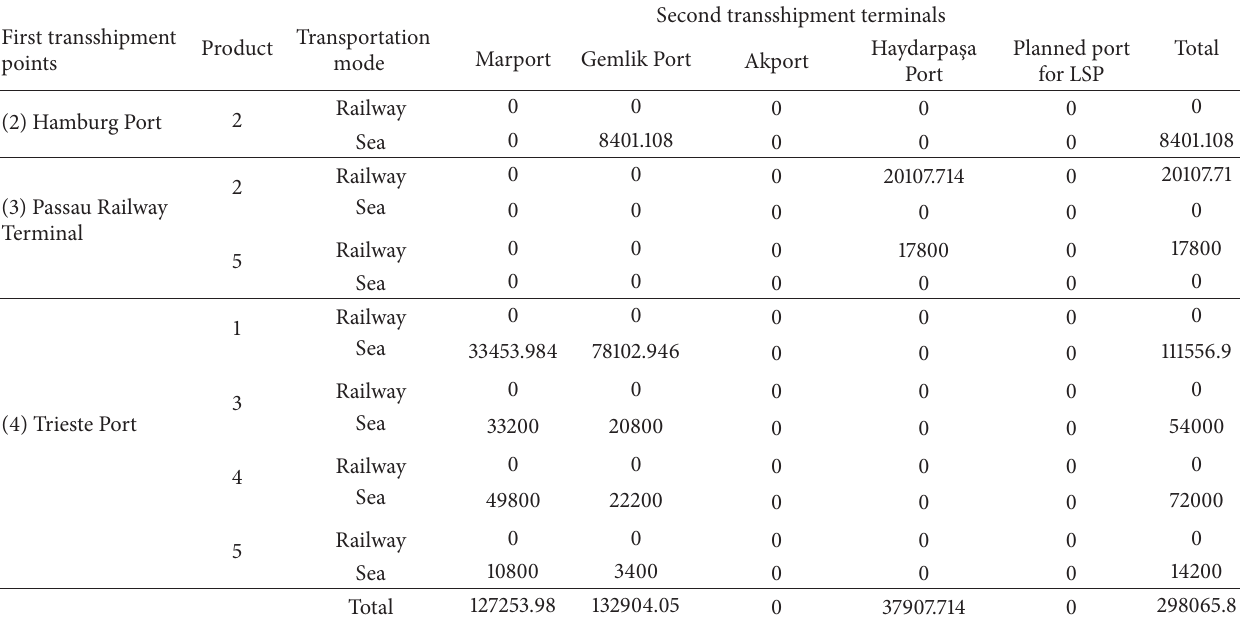
Table 22: Transportation quantities from the first transshipment terminals to the second transshipment terminals.